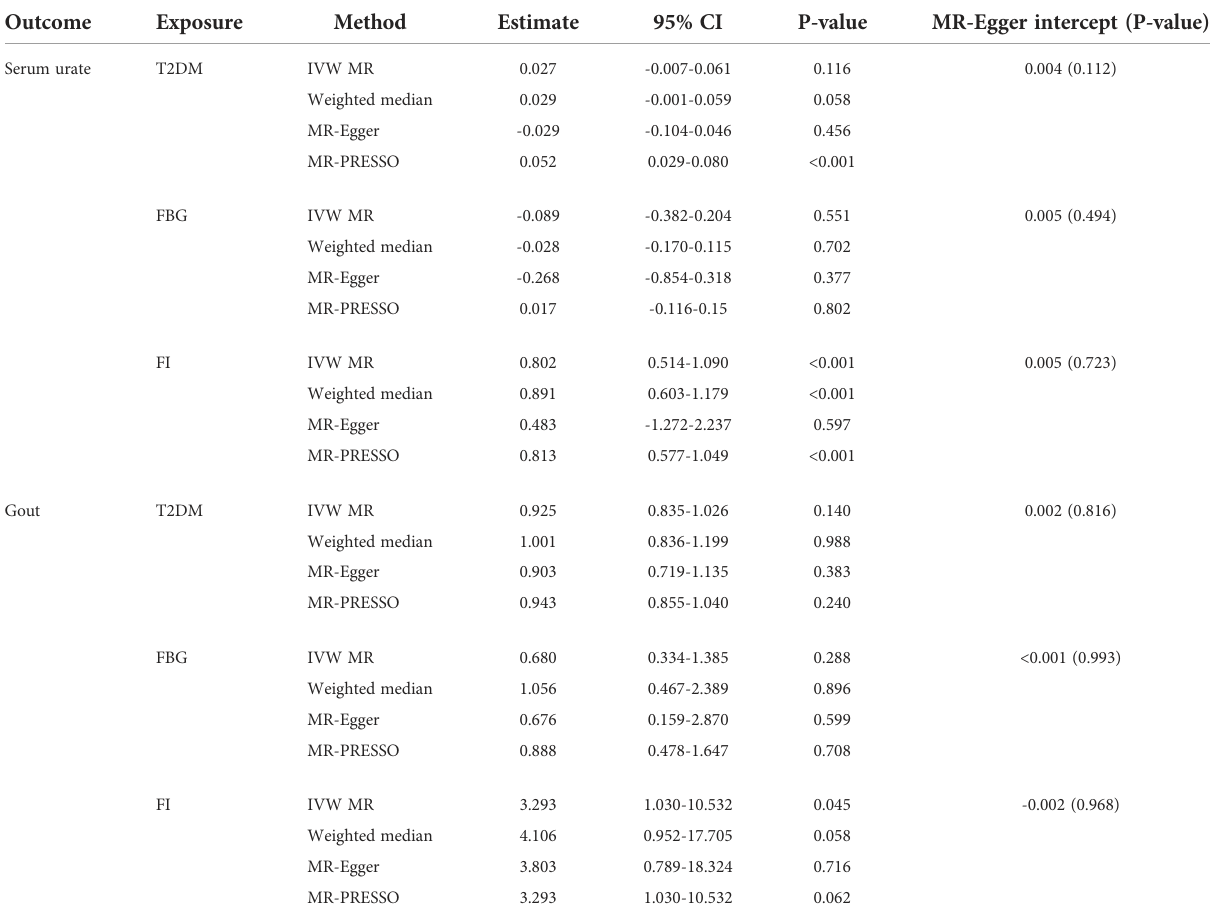
TABLE 2 Mendelian randomization estimates of glycemic traits on serum urate or gout. Outcome